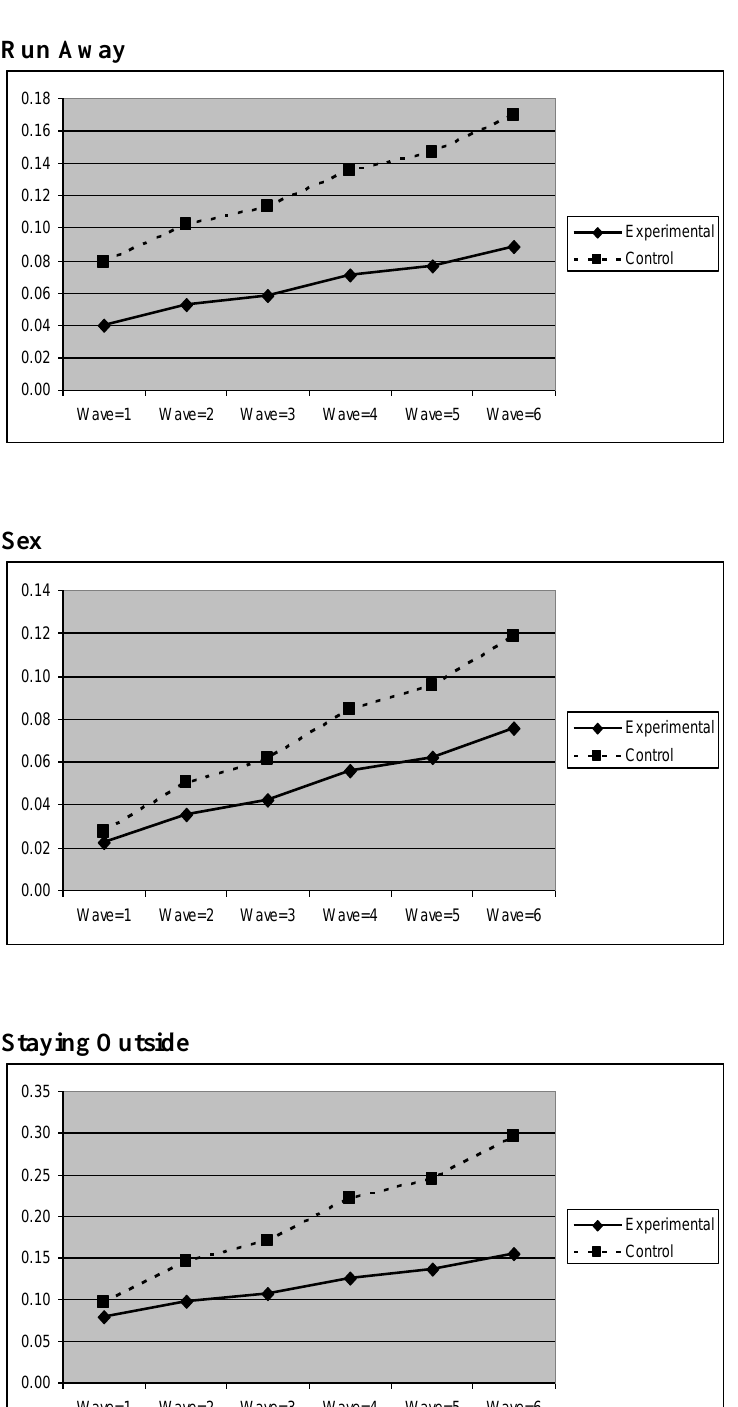
FIGURE 8 . Growth trajectories of the experimental group (participants who joined the Tier 1 Program only) and control group using the item score of staying outside as the outcome